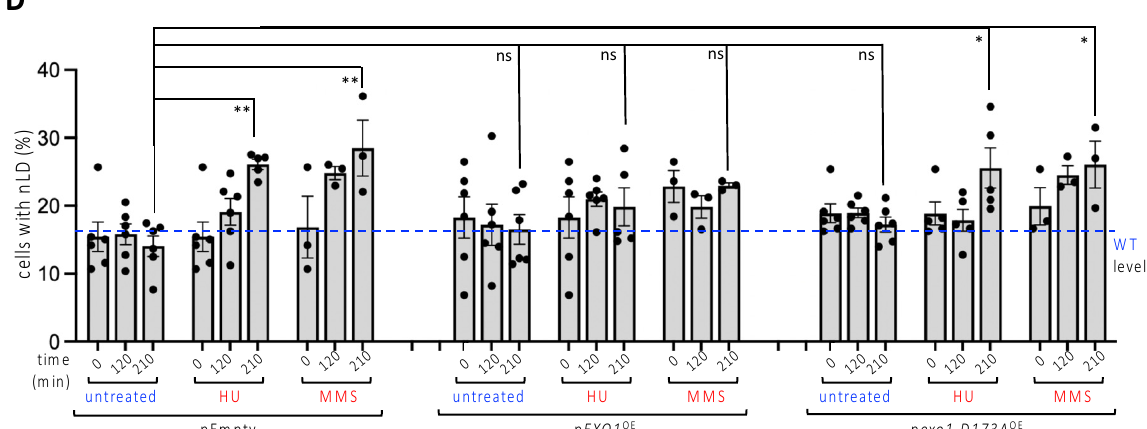
Figure 2. nLD occurrence in response to genetically induced replicative stress. ( A ) Exponentially growing cells of the indicated genotypes were imaged and the experimenter counted the percentage of cells displaying at least one LD in the nucleus (nLD). The measurement of the values at three different times in the absence of any treatment aims to assess whether time has any impact on the frequency of nLD. Each colored dot accounts for one independently performed experiment. Dots of the same color allow for the verification of a trend and the reproducibility in response to a given treatment. The bar heights represent the mean of those independent experiments, and the error bars account for the SEM. A multiple-comparison, one-way ANOVA was applied as indicated and the significance of the difference of the means is indicated by asterisks, where ****, p < 0.0001. At least 300 cells were counted per condition, time point and experiment. The level of the WT samples is provided for comparison, indicated by a blue dashed line. ( B ) Cytometry analysis of exponentially growing